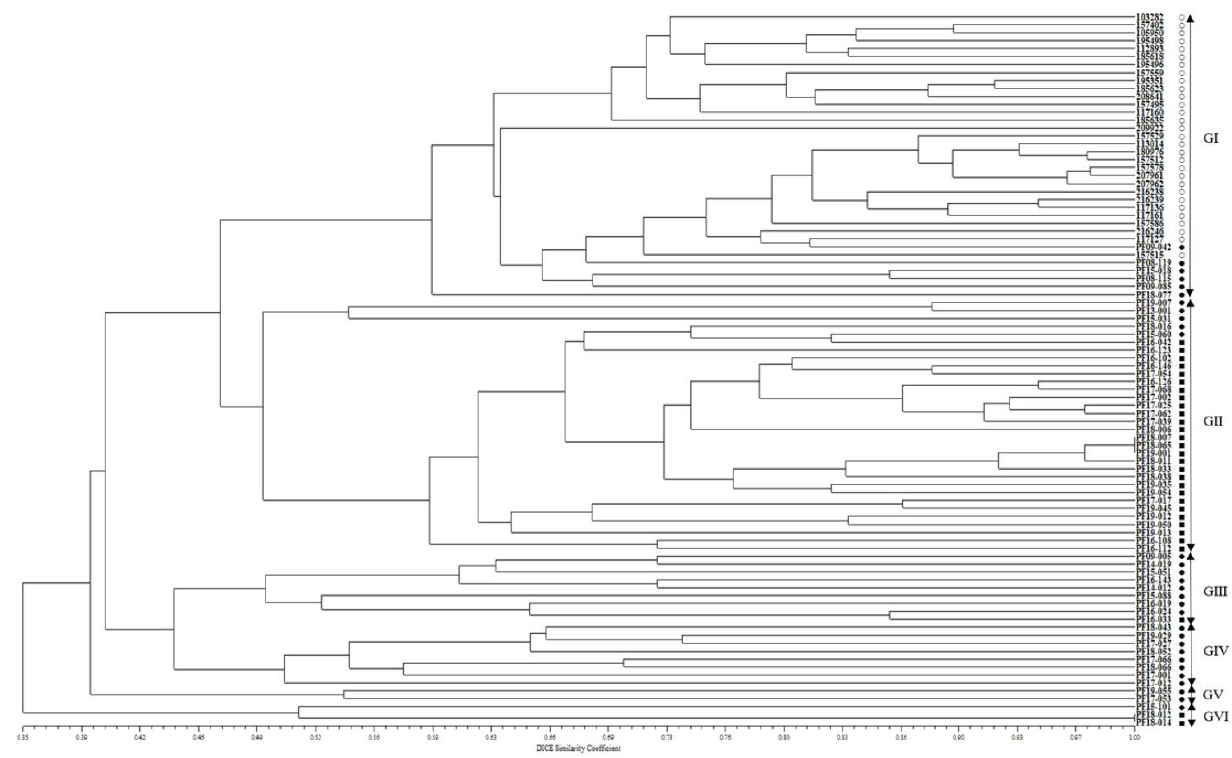
Figure 2. UPGMA dendrogram of 90 Perilla accessions collected from South Korea based on new 17 Perilla SSR